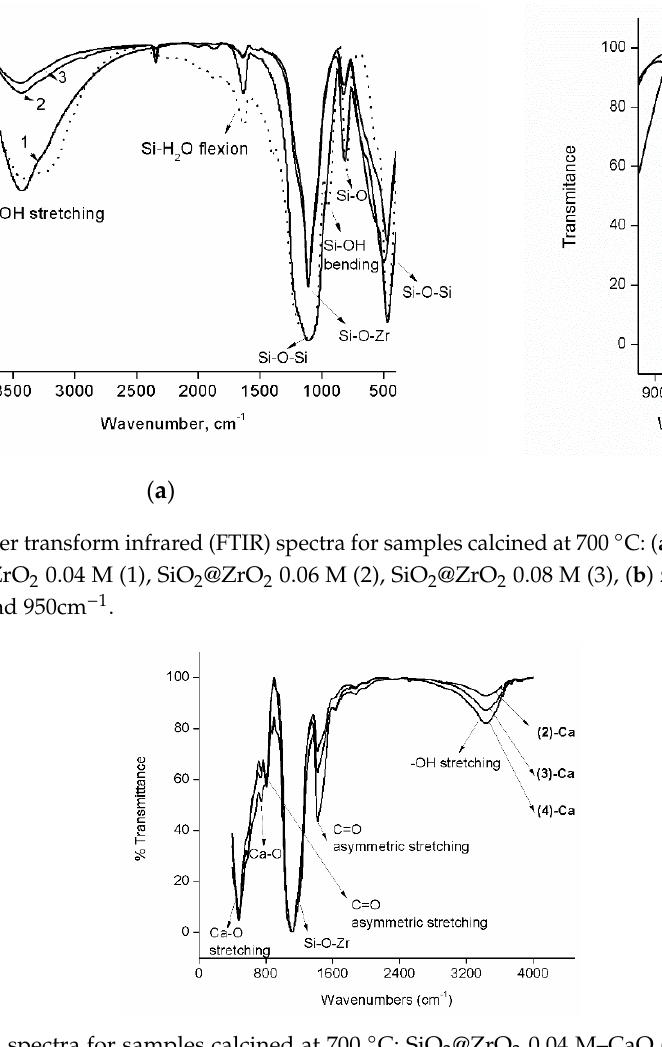
Figure 8. FTIR spectra for samples calcined at 700 ° C: SiO 2 @ZrO 2 0.04M–CaO (2)-Ca, SiO 2 @ZrO 2 0.06M–CaO (3)-Ca, SiO 2 @ZrO 2 0.08M–CaO (4)-Ca.